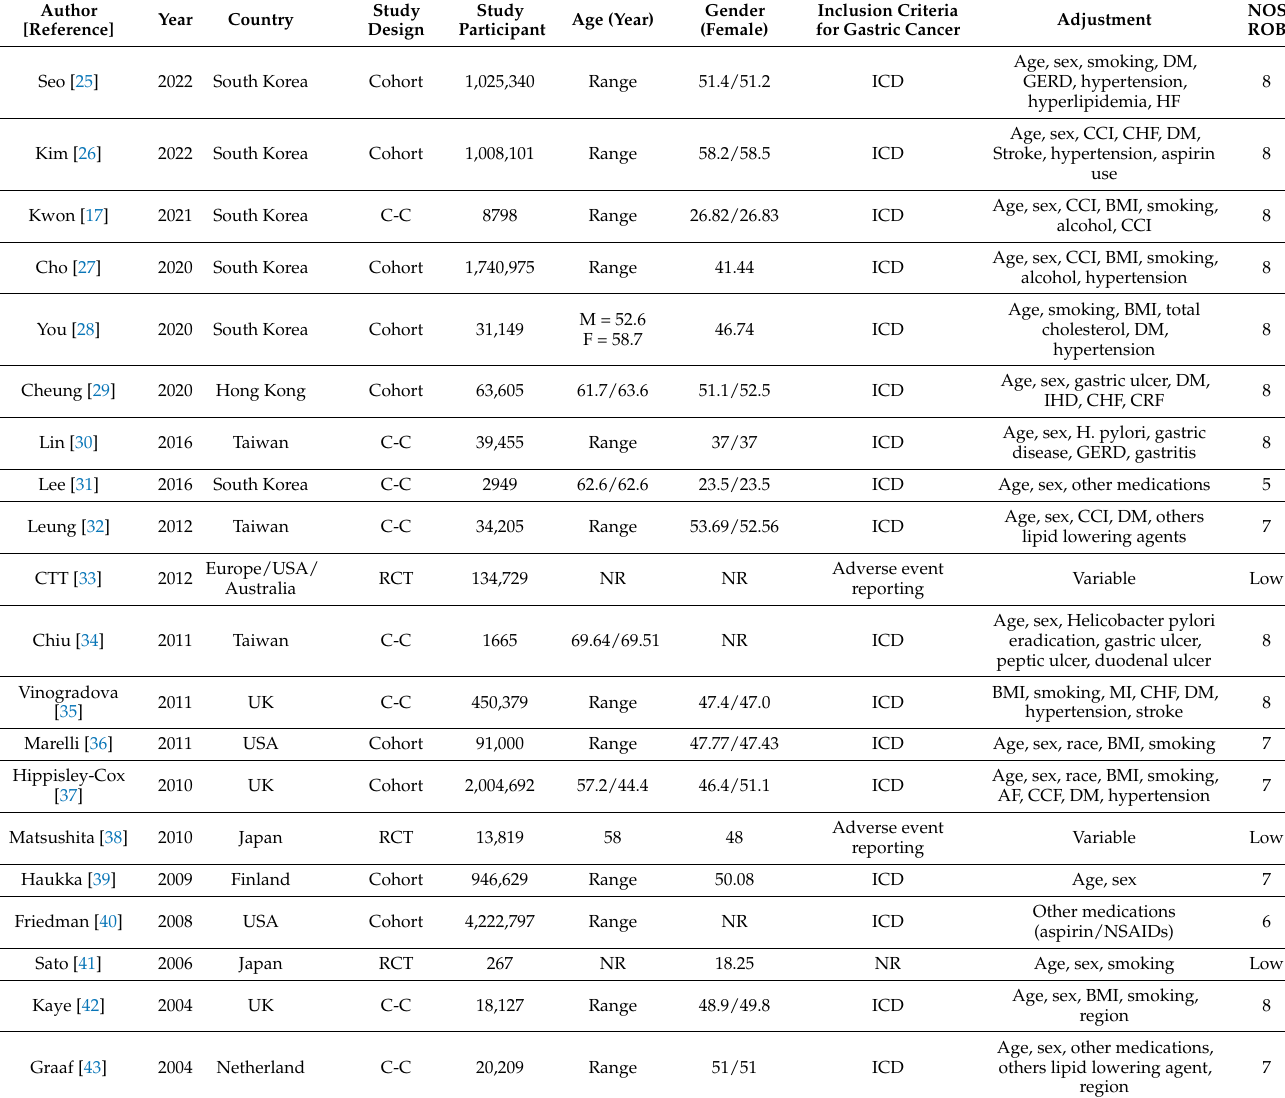
Table 1. Basic characteristics of included